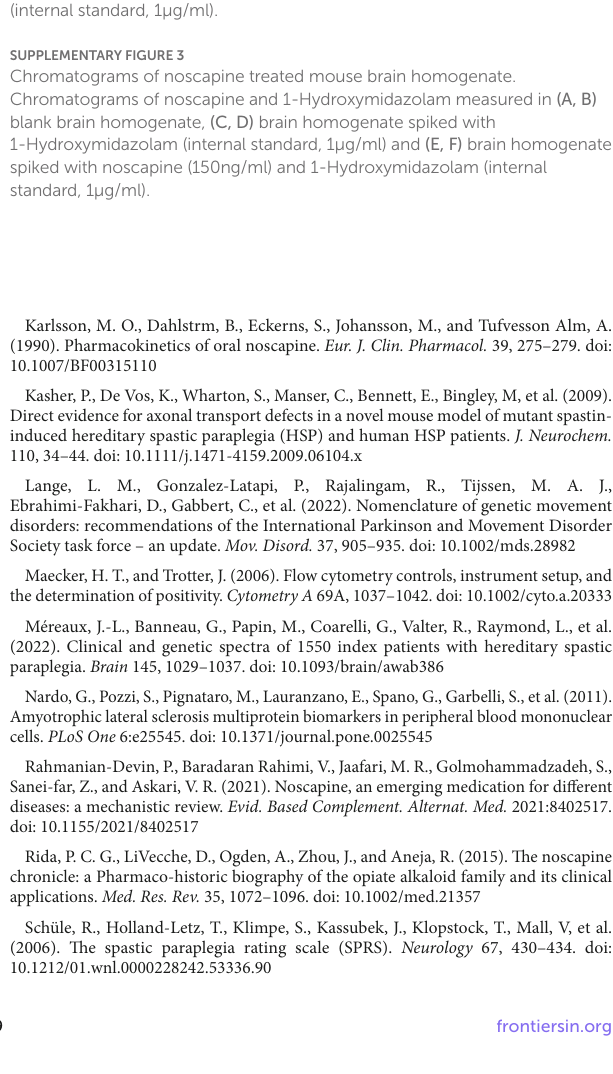
SUPPLEMENTARY FIGURE 1 Correlation of control and HSP- SPAST patient acetylated α -tubulin levels to age. Acetylated α -tubulin levels in controls (A) and HSP- SPAST patient (B) PBMCs were correlated to their age. Pearson correlation coefficient showed no age-related correlation with acetylated α -tubulin levels in both control (R 2 : 0.03) and patient groups (R 2 : 0.22). SUPPLEMENTARY FIGURE 2 Chromatograms of noscapine treated mouse plasma. Chromatograms of noscapine and 1-Hydroxymidazolam measured in (A, B) blank plasma, (C, D) plasma spiked with 1-Hydroxymidazolam (internal standard, 1µg/ml) and (E, F) plasma spiked with noscapine (150ng/ml) and 1-Hydroxymidazolam (internal standard, 1µg/ml). SUPPLEMENTARY FIGURE 3 Chromatograms of noscapine treated mouse brain homogenate. Chromatograms of noscapine and 1-Hydroxymidazolam measured in (A, B) blank brain homogenate, (C, D) brain homogenate spiked with 1-Hydroxymidazolam (internal standard, 1µg/ml) and (E, F) brain homogenate spiked with noscapine (150ng/ml) and 1-Hydroxymidazolam (internal standard,